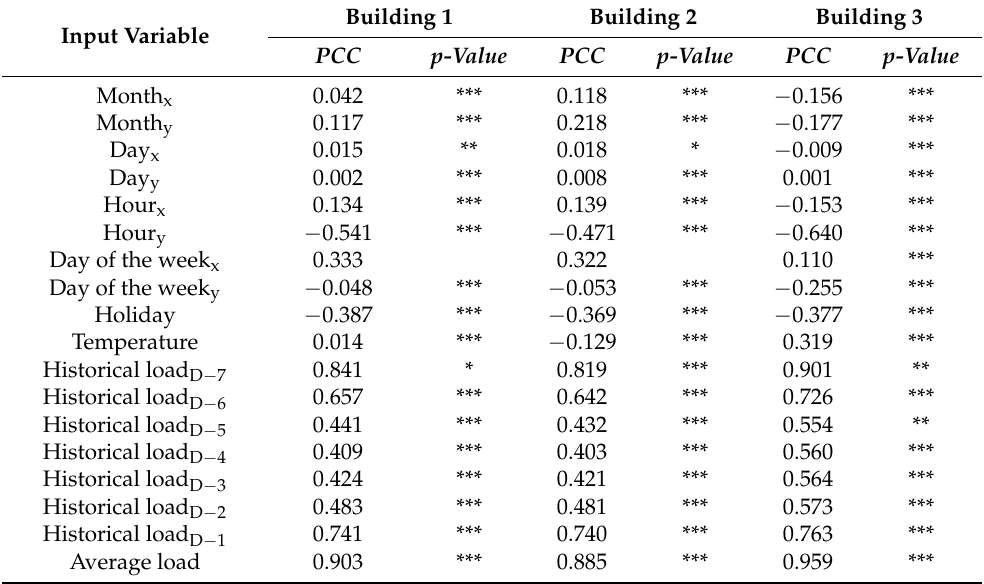
Table 4. Pearson correlation coefficients (PCCs) and p -values for each